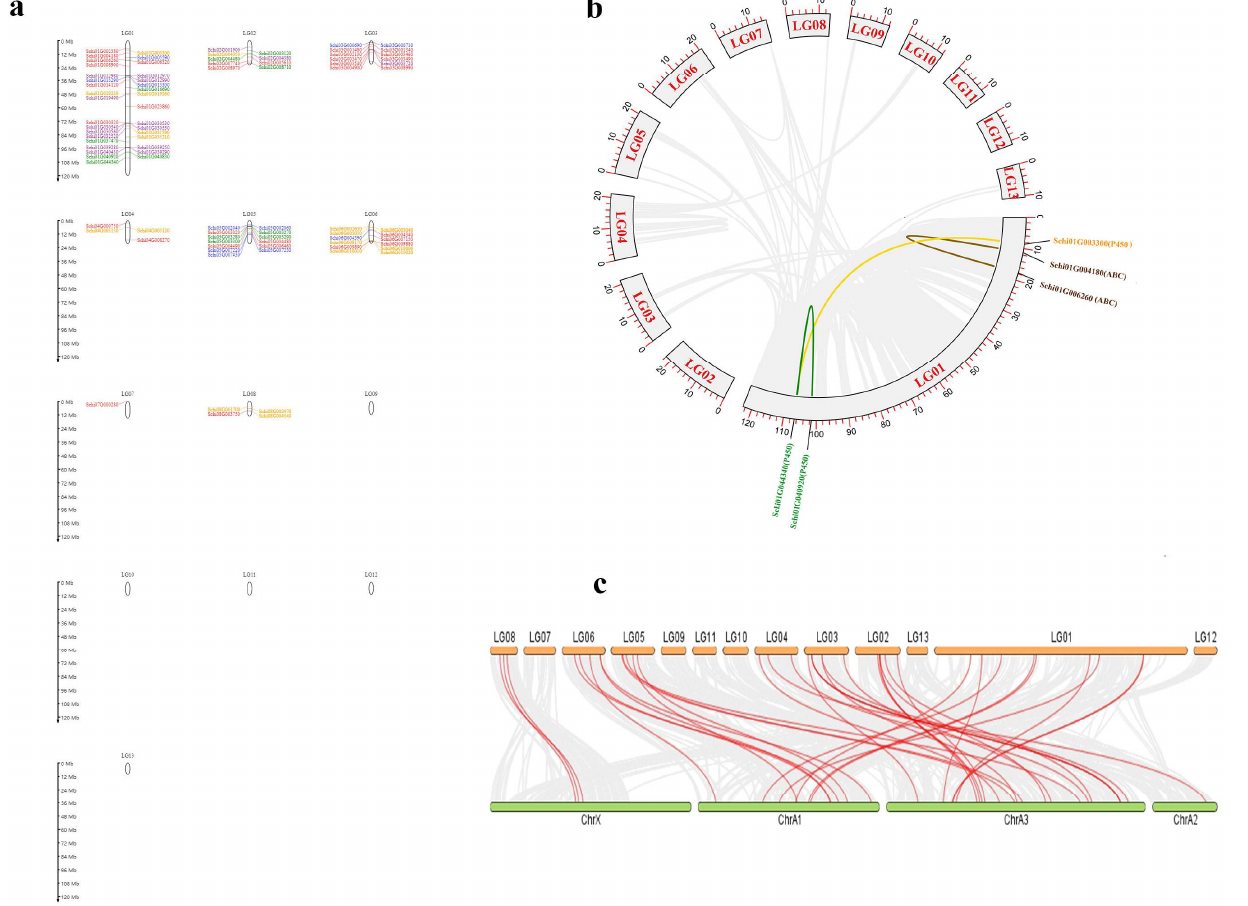
Figure 7. Location and collinearity analysis of all detoxification genes in S. chinensis . ( a ) Scaffold location and gene tandem. Green represent CCEs; Blue represent GSTs; orange represent P450s; purple represent UDPs; Red represent ABCs ( b ) Chromosomal location and collinearity. Grey boxes represent chromosomes. lighted lines connected detoxification gene duplication. ( c ) Synteny on gene families of S. chinensis and A. pisum . Table 3. Expression profiles of detoxification genes in S. chinensis